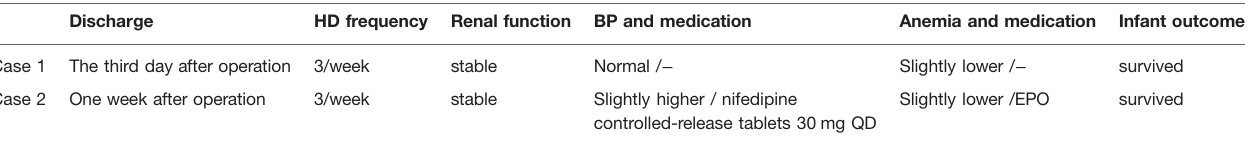
TABLE 2 | Maternal and infant outcomes.